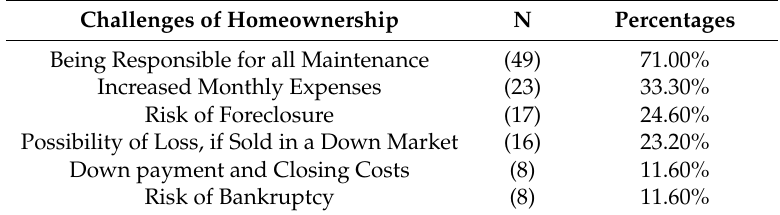
Table 16. Perceived Challenges of Homeownership of Houston Habitat Homeowners